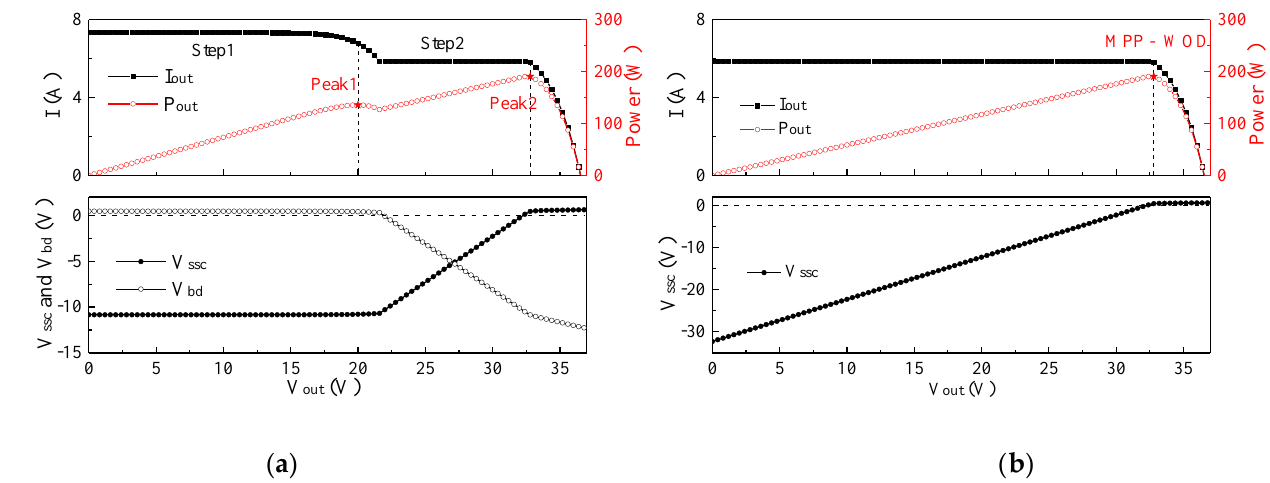
Figure 4. Output characteristics of the simulated PV module, and the terminal voltages of the shadowed solar cell and relevant bypass diode when a solar cell receives a shadow across 20% of its area: ( a ) module with bypass diode, ( b ) module without bypass diode.